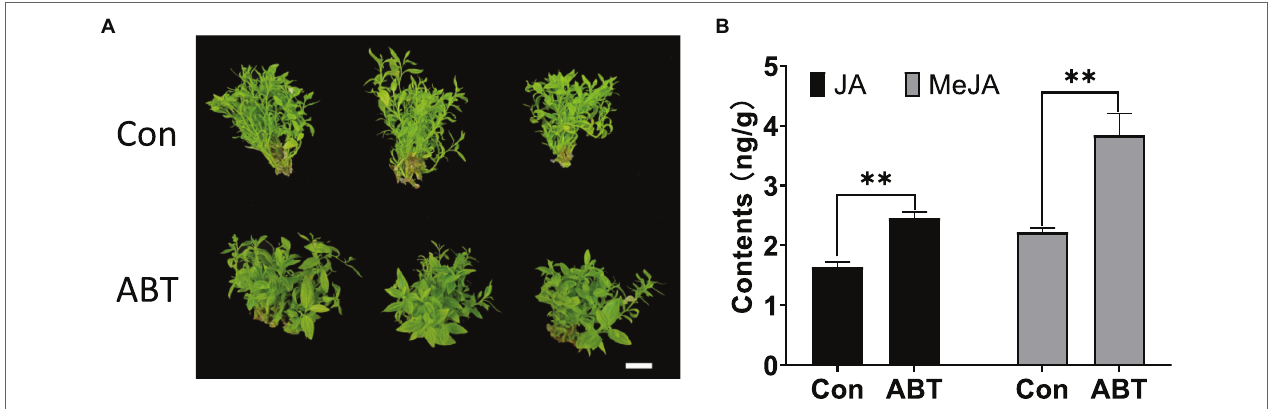
FIGURE 9 | The phenotype of witches’ broom symptoms (A) and contents of JA and MeJA (B) in DH2 tissue culture after 1-aminobenzotriazole (ABT) treatment for 1 month. White bars are 1 cm. * p < 0.05; and ** p <